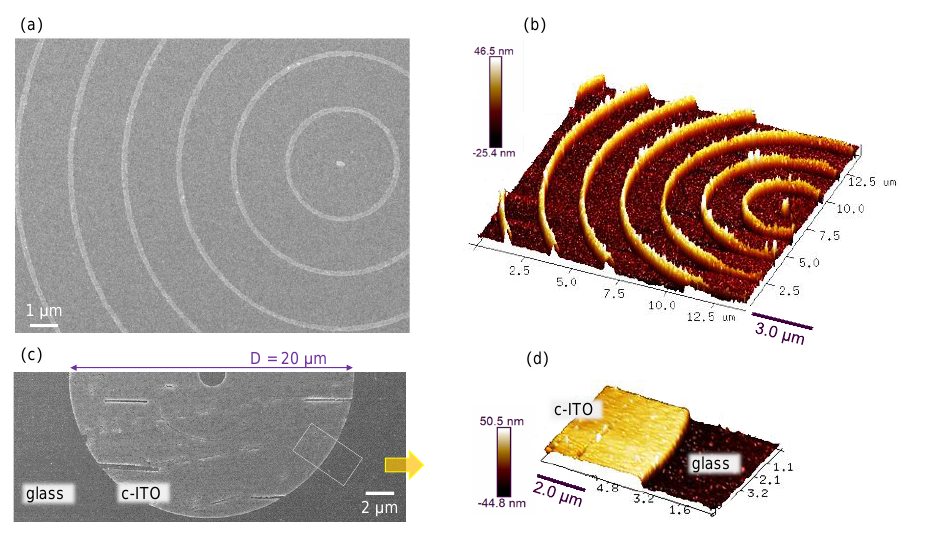
Figure 5. ( a ) SEM image of a Bessel-beam generating a micro-optical element recorded on glass. Polarisation of laser E-field was horizontal, NA = 0.9, scanning speed v s = 30 µ m/s and pulse energy E p = 0.9 nJ (on sample). ( b ) AFM view of the concentric grating with ITO lines that were 60 nm in height. ( c ) Bulk c-ITO recorded on glass. ( d ) AFM view of the bulk of